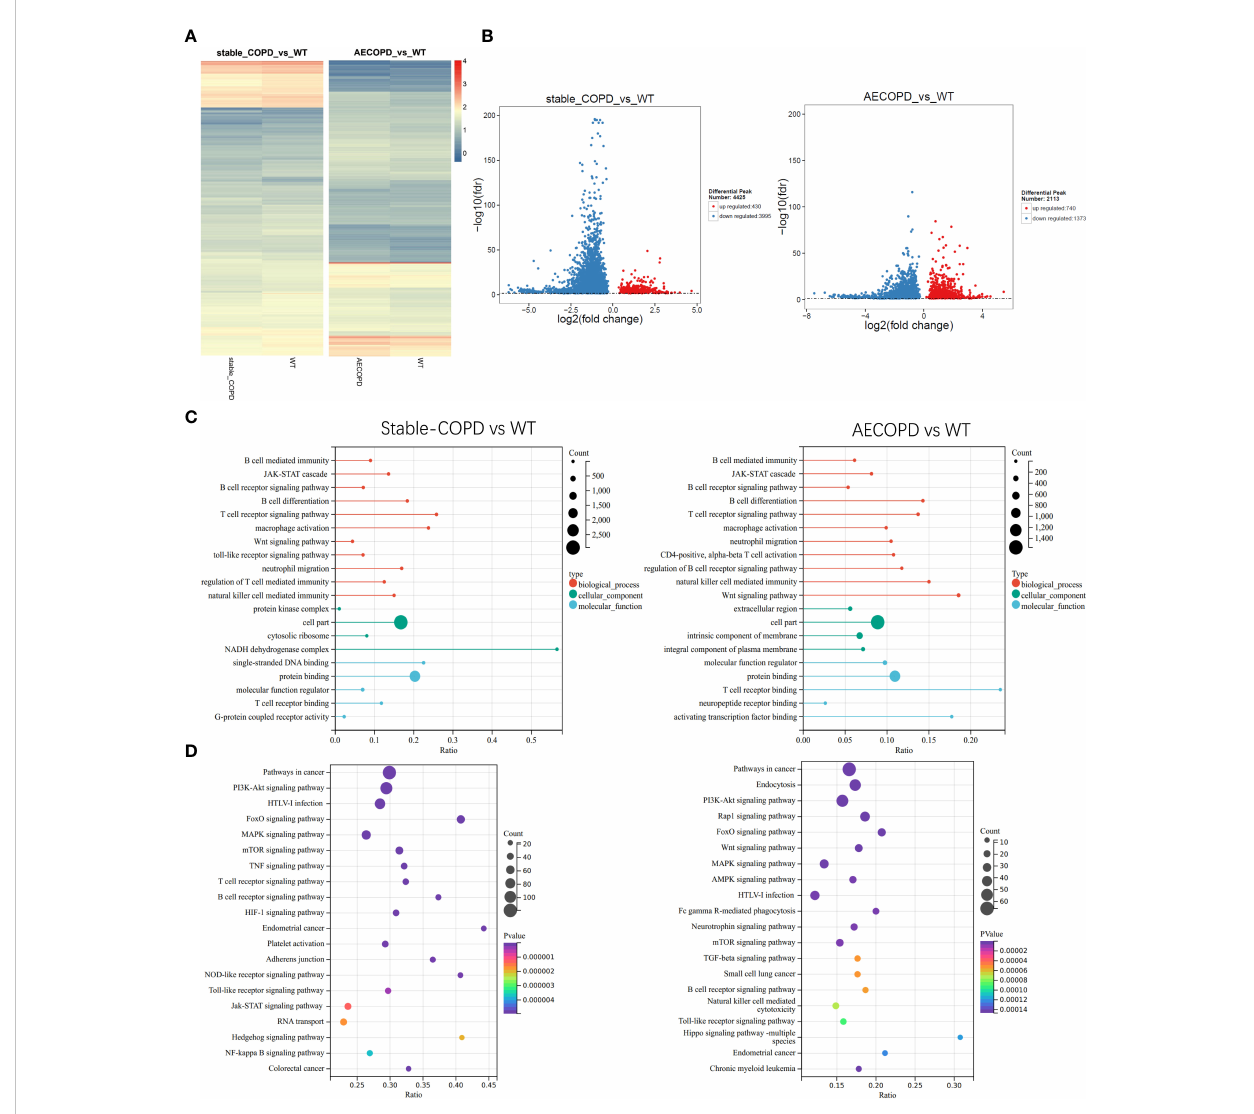
FIGURE 6 Gene Ontology and Kyoto Encyclopedia of Gene and Genomes analyses: (A, B) Heat map and volcano map show the m6A-modi fi ed differentially expressed genes (DEGs) between the control group and stable COPD and AECOPD groups. (C) GO terminologies of m6A-modi fi ed DEGs between the control group and stable COPD and AECOPD groups. (D) Twenty pathways of m6A-modi fi ed DEGs between the control group and stable COPD and AECOPD